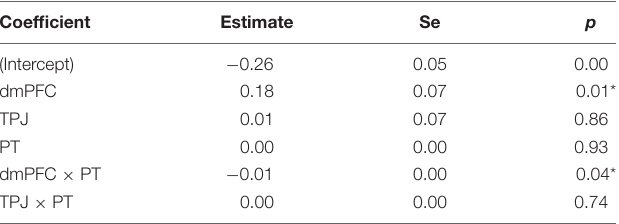
TABLE 2 | Regression analysis indicating the effects of tDCS treatment, and perspective taking on log altruism. Coefficient